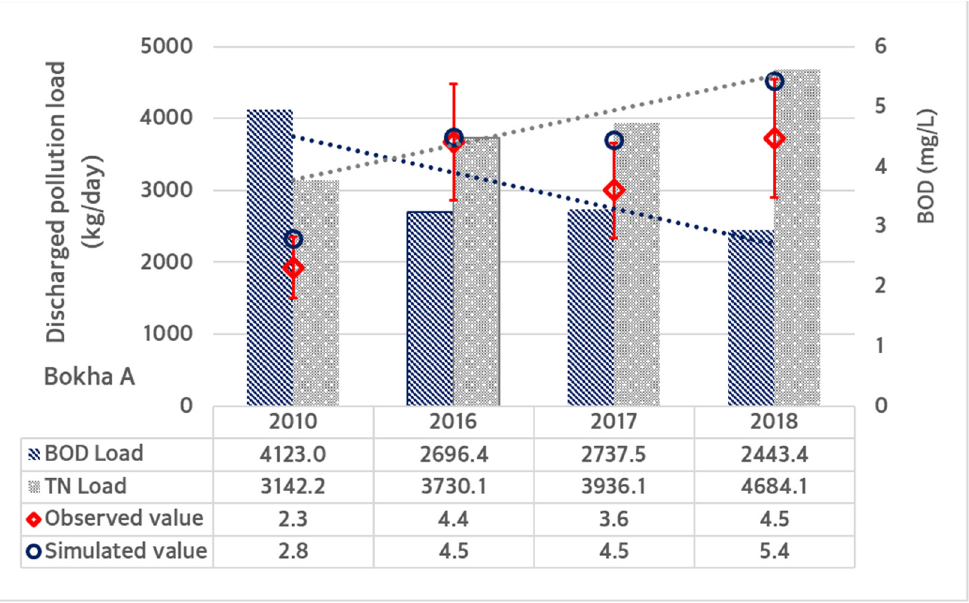
Figure 5. Verification of the reproduction of BOD 5 based on 2016.